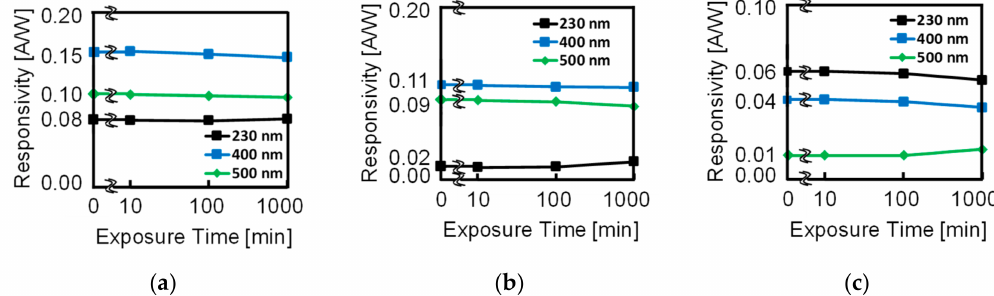
Figure 12. Measurement results of the robustness to UV light for ( a ) PD1, ( b ) PD2 and ( c ) PD1 – PD2.